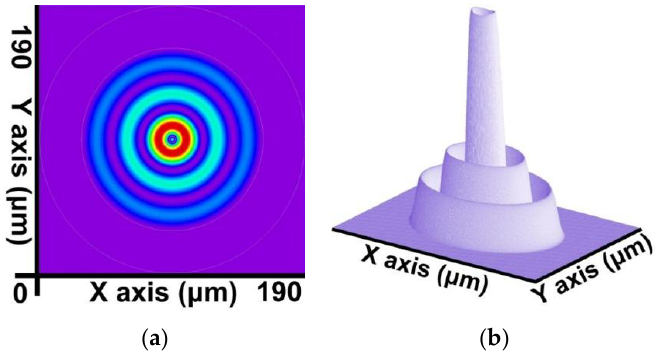
Figure 10. The 2D and 3D power distribution patterns of the cladding modes (v = 20) with an effective refractive index of 41.42962604 20 eff n . ( a ) 2D power distribution; ( b ) 3D power distribution.